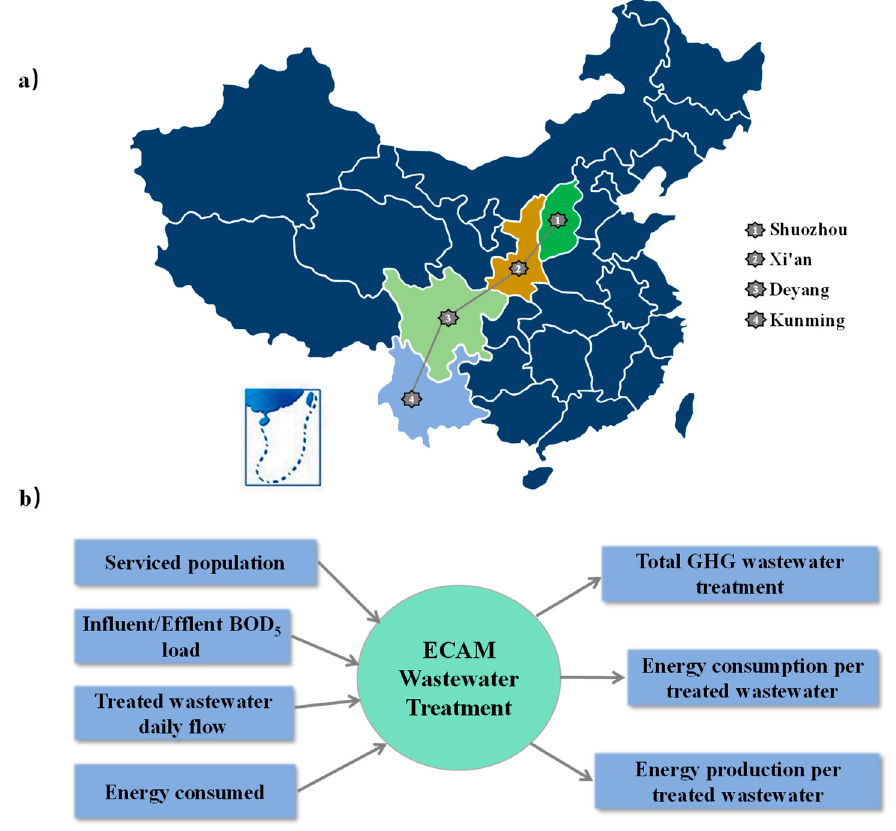
Figure 1. Urban location of wastewater treatment process ( a ) and the main input and output data of ECAM tool ( b ).